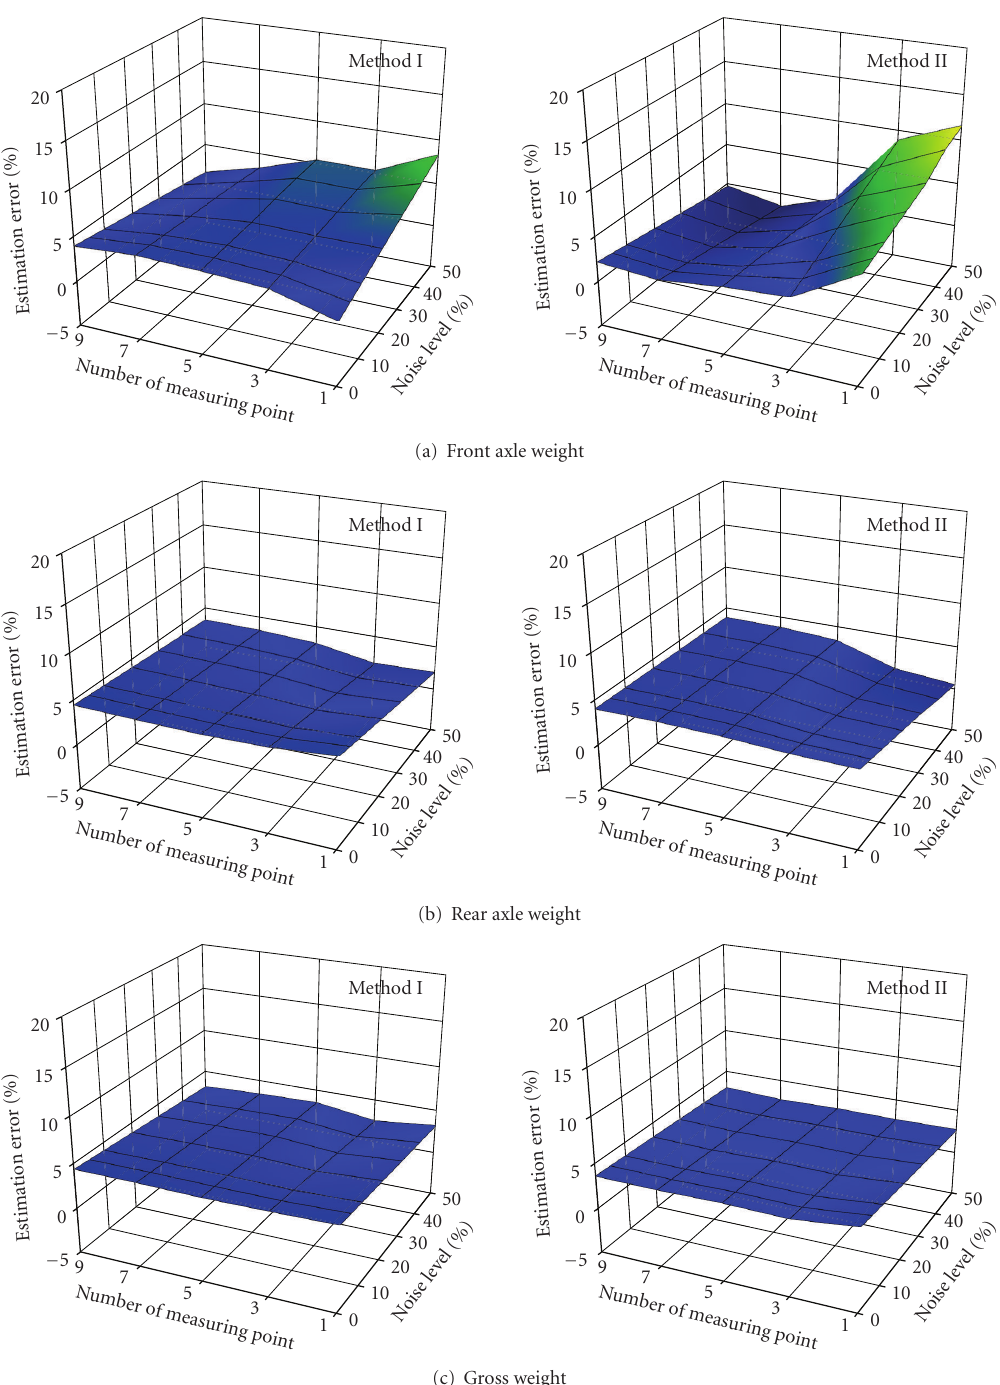
Figure 8: Estimation errors of axle weights under various numbers of measuring points and noise levels for (a) front axle weight, (b) rear axle weight, and (c) gross